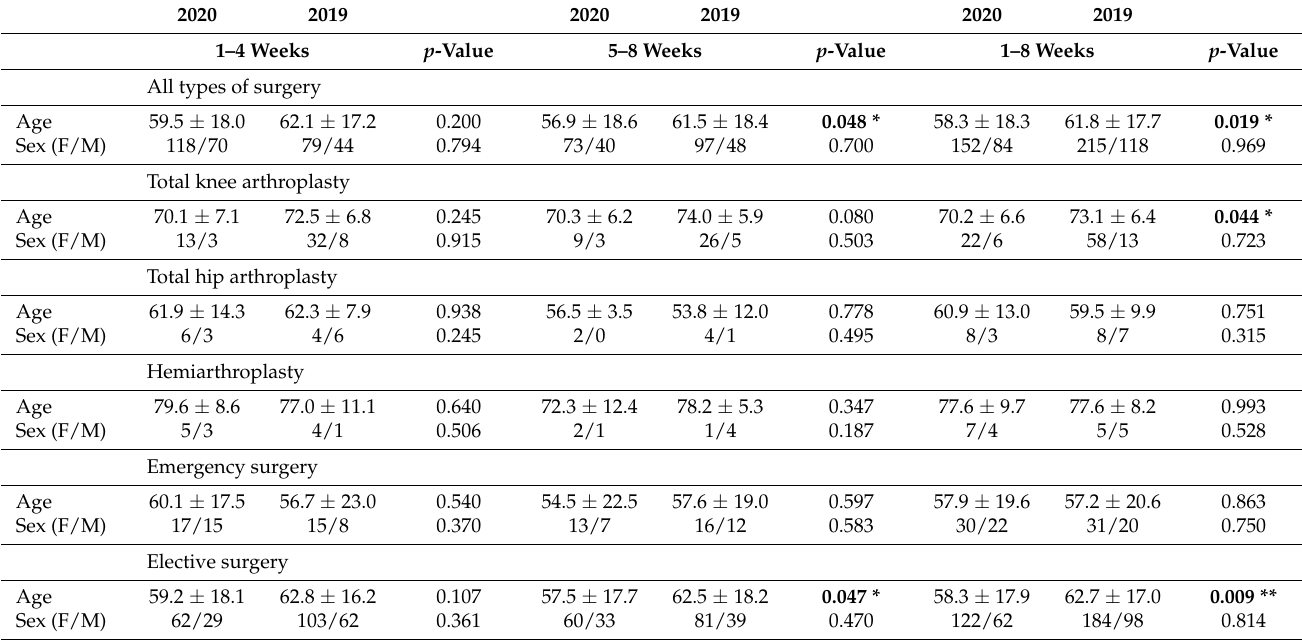
Table 1. Major characteristics of patients receiving total knee arthroplasty, total hip arthroplasty, or hemiarthroplasty surgery at the community hospital during the study (2020) and control (2019) periods; ** p ≤ 0.01, * p ≤